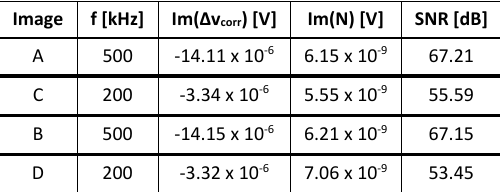
Table 5: Some quantitative data on the corrected signals